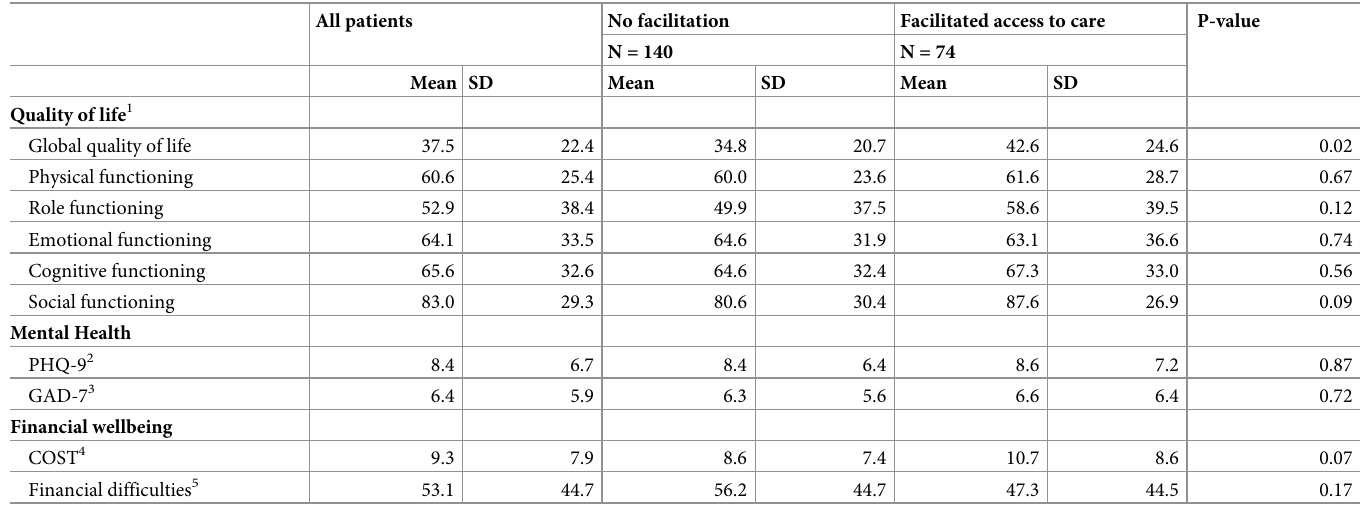
SD: standard deviation from the mean scores